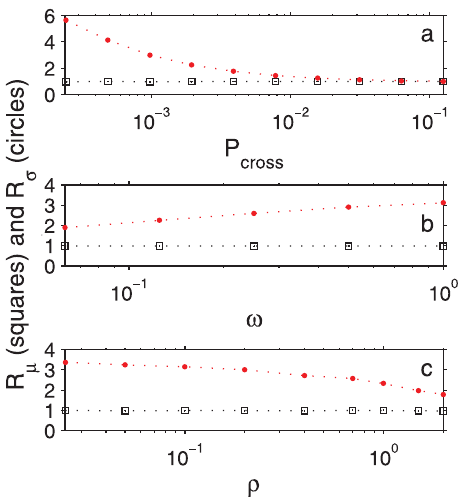
Figure 3. Behavior of the ratio of the mean and standard deviation of the time between reactions in the presence of confining domains to that in the absence of confining domains, denoted by R m and R s , respectively (see text). Data obtained by Monte Carlo simulations. a. the dependence of R m and R s on confinement strength characterized by P cross . P cross takes on values between 2 { 12 and 2 { 3 . Other parameter values are: v ~ 1 , N ~ 200 , L ~ 20 a , t dim ~ 1 , r ~ 0 : 1 . b. R m and R s as a function of reaction probability v , with other parameters fixed at: P cross ~ 9 | 10 { 4 , N ~ 200 , L ~ 20 a , t dim ~ 1 , r ~ 0 : 1 . c. density dependence of R m and R s . In this case v ~ 1 , N ~ 400 , L ~ 20 a , t dim ~ 1 , and the density r varies between 0.05 and 2 molecules per compartment. Error bars in all plots are smaller than the data points.